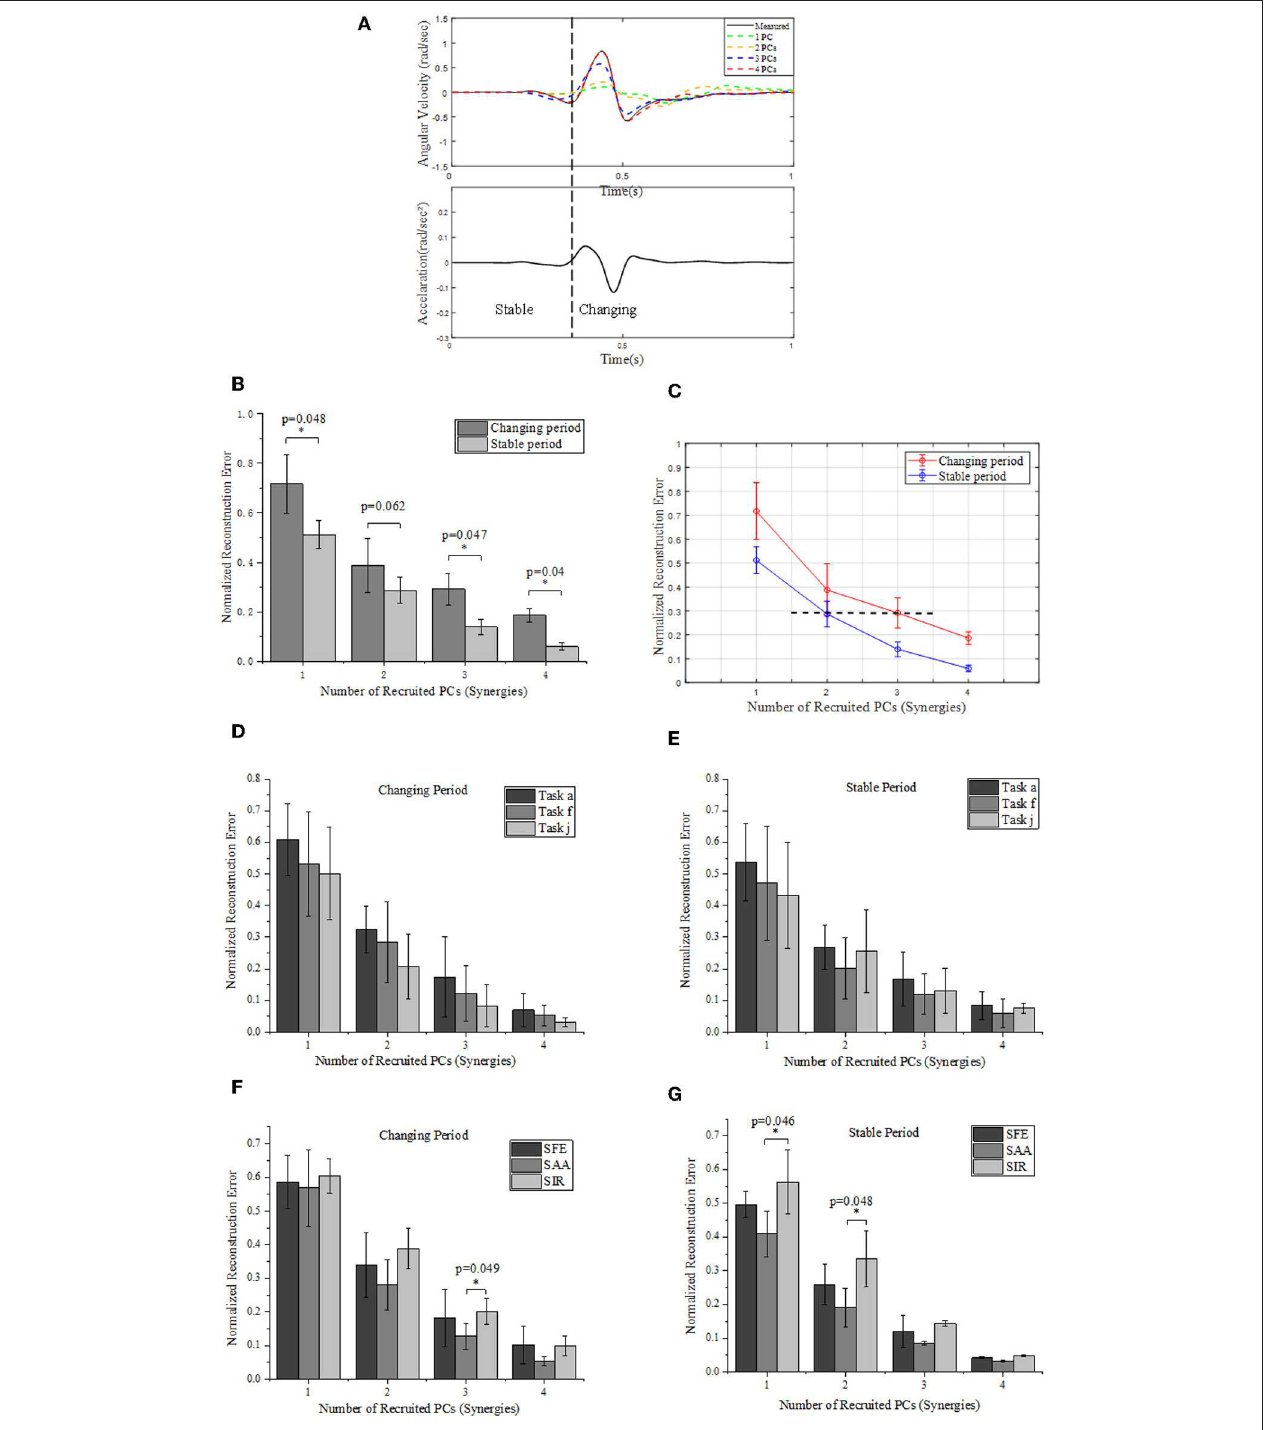
FIGURE 7 | (A) Comparison between the measured (solid) and reconstructed (dashed) angular velocity for shoulder abduction of task “a” ( Figure 2B ) (upper), and the corresponding acceleration of movement (lower). The reconstructed angular velocities presented on the upper plots are calculated based on different numbers of PCs. (B) Reconstruction errors of angular velocities within stable and changing periods, respectively. (C) Relationships of normalized reconstruction errors against number of PCs (synergies) for angular velocity reconstruction. (D,E) Grouped comparison of the impact of synergy number and target position on reconstruction errors in “changing” or “stable” periods. (F,G) Grouped comparison of the impact of synergy number and shoulder DOFs on reconstruction errors in “changing” or “stable” periods (*indicates p < 0.05).